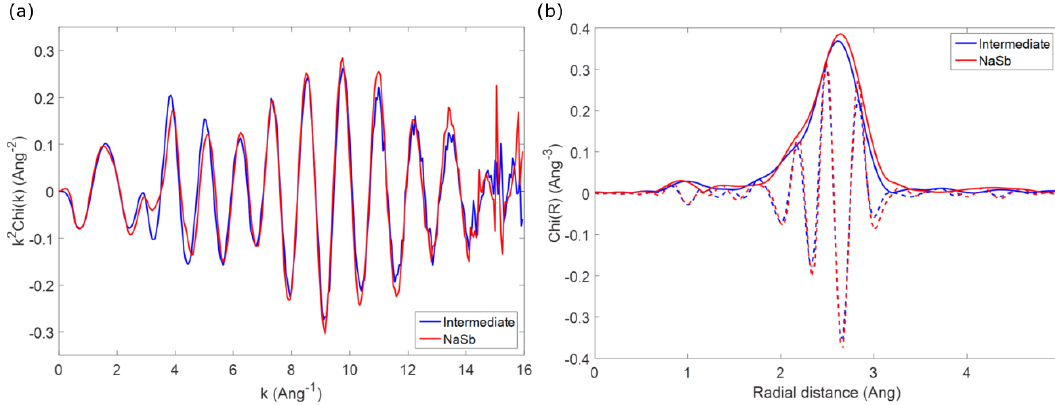
Figure 5. EXAFS spectra ( a ) and respective Fourier Transform ( b ) of NaSb (red) and of the Sb electrode after the reaction of about 1mol Na per mol of Sb during the second discharge